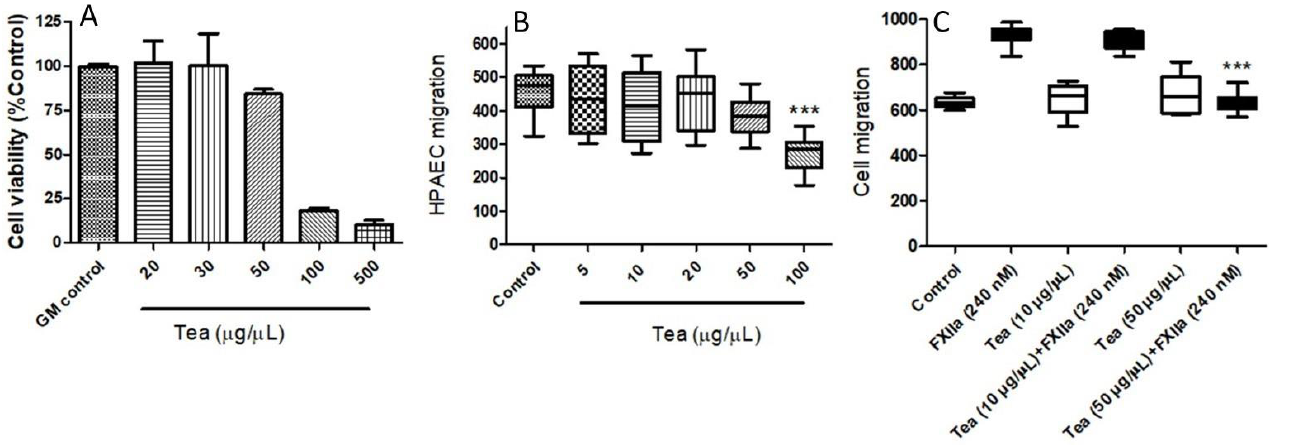
Figure 7. Showing cell viability and cell migration. ( A ) Effect of tea water extract on HPAEC viability. MTT assay was performed to measure cell viability (by percent) in response to tea water extract treatment. HPAECs treated with tea water extract using the MTT assay. The complete growth medium (GM) was used as a control. Data represent the mean ± SEM of three experiments (*** p < 0.01 compared to untreated control). ( B ) Effect of tea water extract on HPAEC migration in the absence of activated FXII. Cells were seeded, cultured, and allowed to grow to near confluence. Confluent monolayers were carefully wounded and the cellular debris was gently washed away with PBS. Cells were treated with increasing concentrations of tea water extracts. Each bar represents nine runs. Statistical significance was measured with the two-way ANOVA. *** p < 0.001 compared to control. ( C ) Effect of tea water extract on HPAEC migration in the presence of activated FXII (FXIIa). Cells were seeded, cultured, and allowed to grow to near confluence. Confluent monolayers were carefully wounded and the cellular debris was gently washed away with PBS. Cells were treated with various concentrations of tea water extracts in the presence of FXIIa. For panel C, each bar represents nine runs (*** p < 0.001 compared to FXIIa).